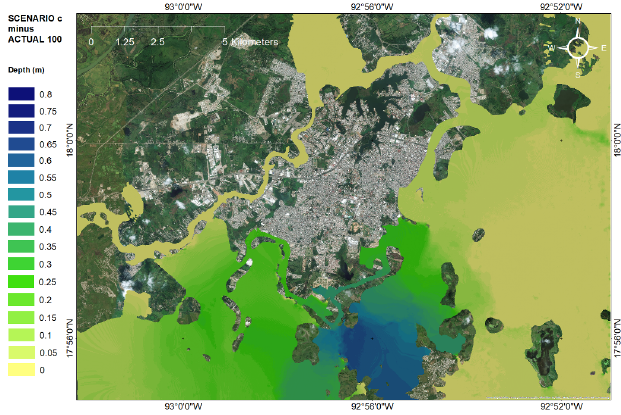
Figure 9. Differences in the water depth between Scenario B (2050) and the current situation.